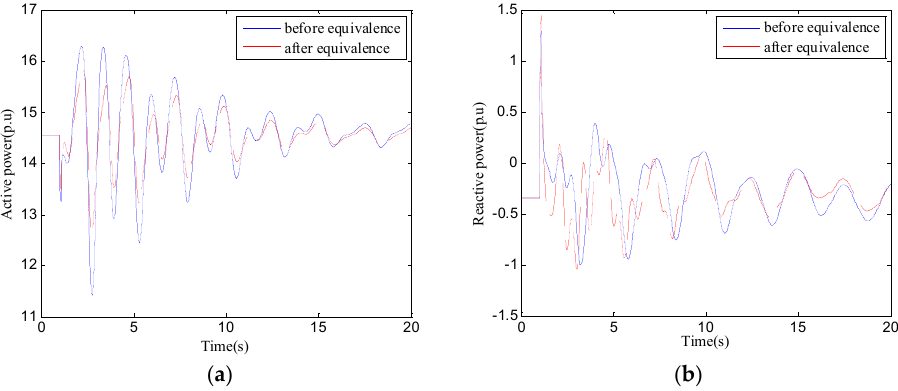
Figure 11. ( a ) Active power curves between before and after equivalence; ( b ) reactive power curves